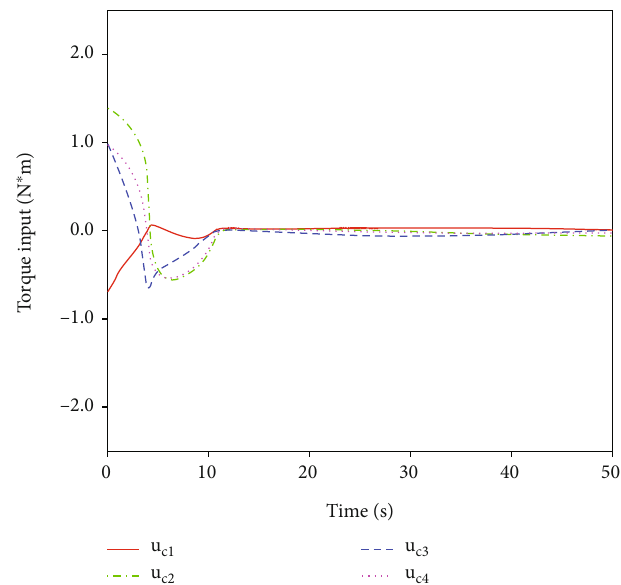
Figure 4: Time response of controlling torque.